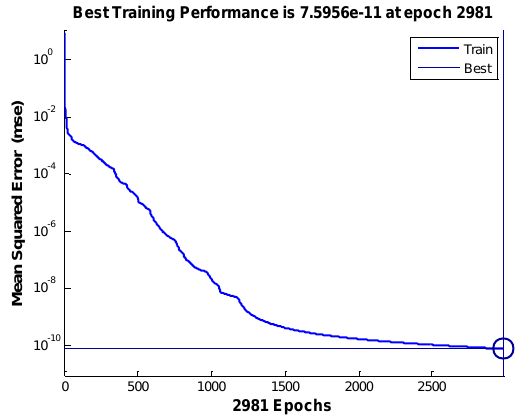
Figure 5. Regression of the ANN-BBSA optimization.